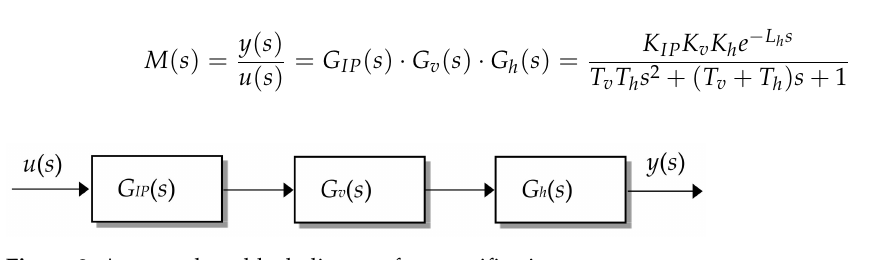
Figure 2. An open-loop block diagram for regasification system.